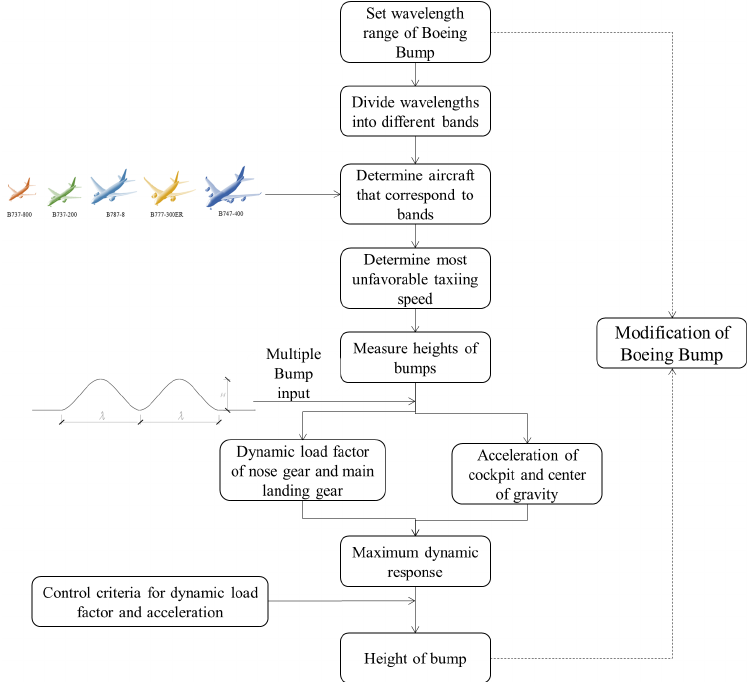
Figure 8. Modification process for Boeing Bump Index